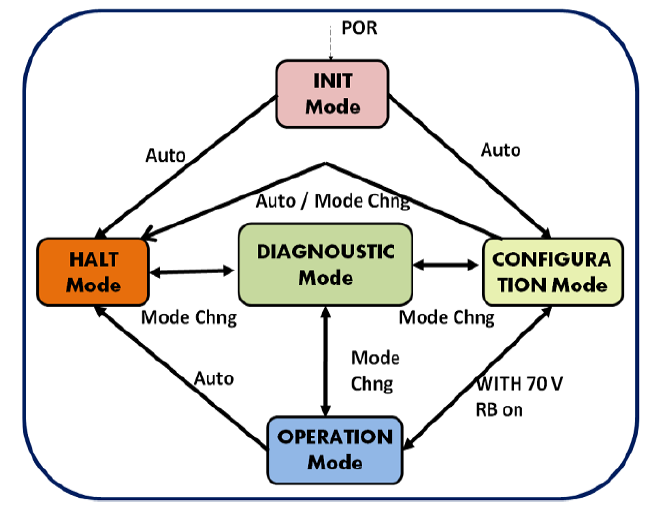
Figure 1. Different modes of